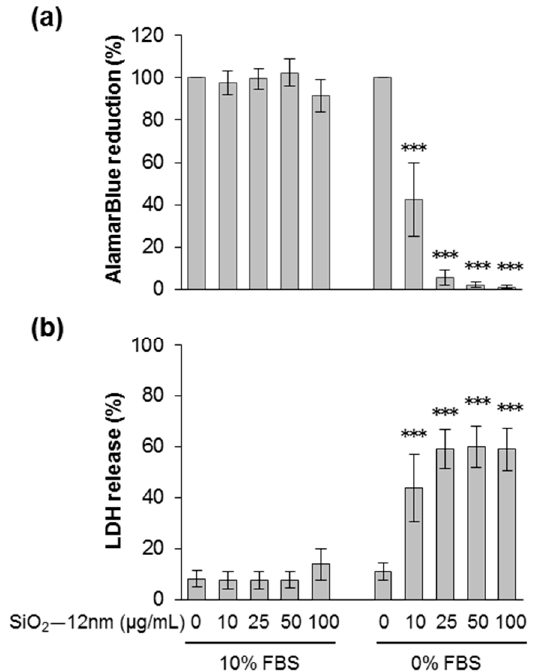
Figure 1. Cell viability decreased after incubation with silica NPs in the absence of fetal bovine serum (FBS). HCT116 wt cells were incubated with SiO 2 —12 nm NPs at the indicated concentration in the presence or absence of 10% FBS. After 24 h, cell viability was detected by the AlamarBlue assay ( a ). The values were normalized to the negative control (no particles were added, 100%). Lactate dehydrogenase (LDH) release is shown in ( b ). The values were normalized to the positive control (1% Triton X-100, 100%). The data represent the means of seven independent experiments ± SD performed with six replicates. *** p < 0.001 indicates significant di ff erences in the response of cells treated with the same amount of NPs in the absence (0% FBS) or the presence of serum (10%